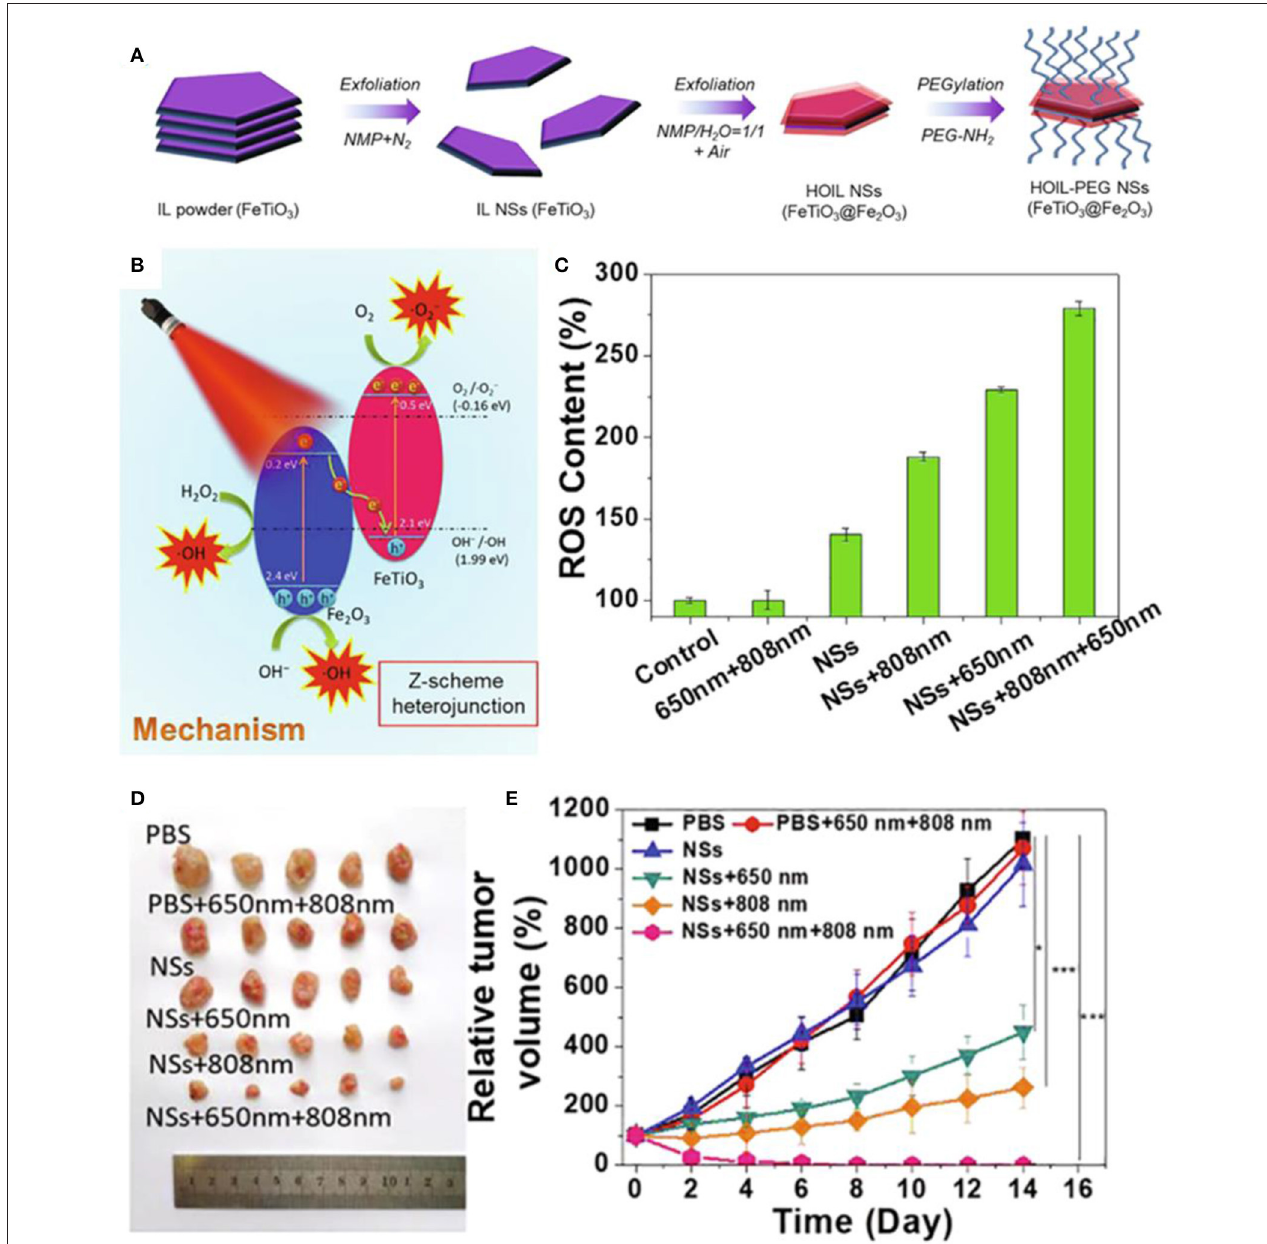
FIGURE 8 | (A,B) Schematic illustration of fabrication and therapy mechanism of HOIL-PEG NSs. (C) ROS content of A549 cells after treated. (D) Morphology of representative tumors. (E) Tumor volume of A549 tumor-bearing nude mice after treatment. Statistical values are indicated in figures according to the following scale: * P < 0.05,** P < 0.01 and *** P < 0.001. Reproduced, with permission, from Ou et al. (2020). Copyright 2020,